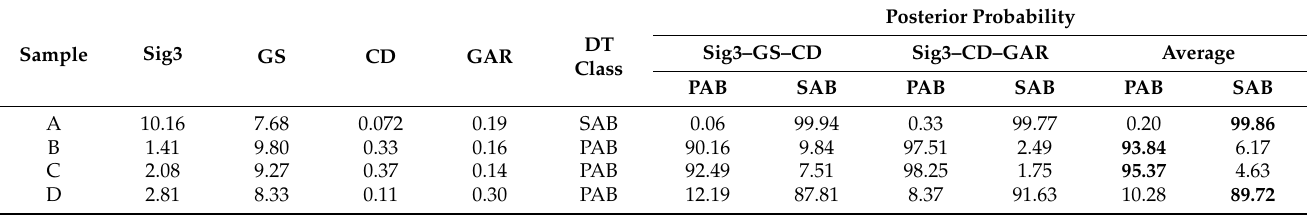
Table 2. Value of the discriminant factors, decision tree predicted classes, and posterior probability of the molten marks at the fire